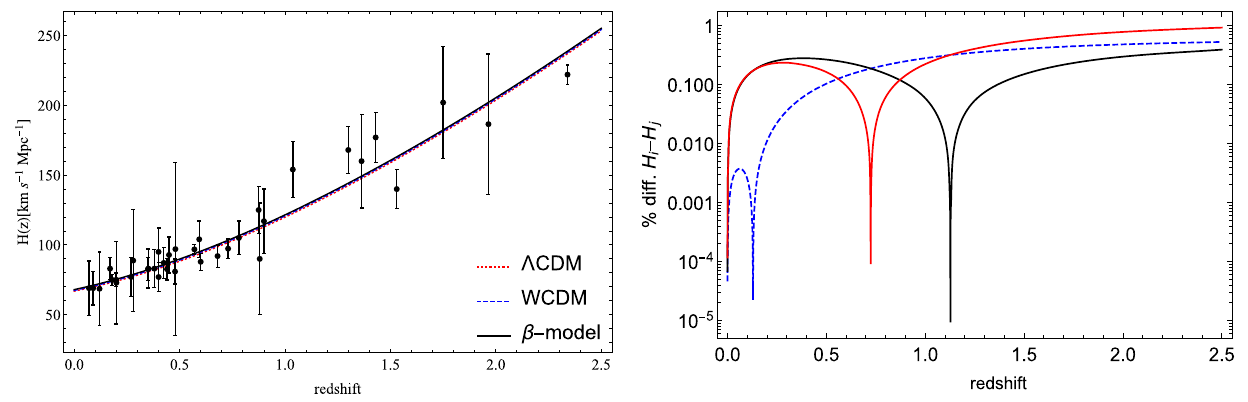
Fig. 3 In the left panel, Hubble function in units of km s − 1 Mpc − 1 is presented with its evolution in terms of redshift. In the right panel, it is shown the percentage difference between the studied models in loga-